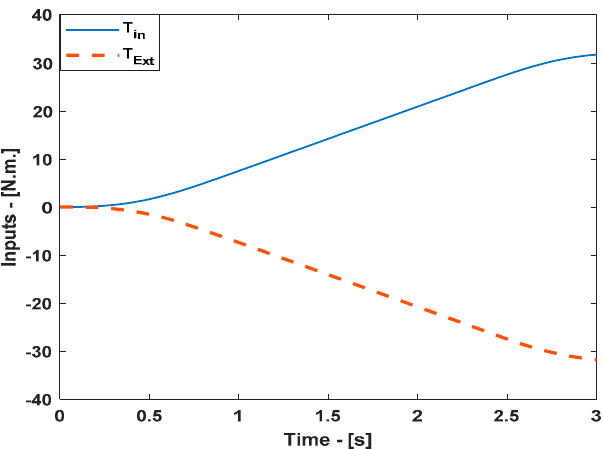
Figure 5. The input signals of BcVSA based on the LQR scheme under the condition when all the = 7 K clutches are active ( 𝐾 (cid:3032)(cid:3044) = 7 𝐾 (cid:2868) ) during the entire simulation time. clutches are active ( K eq 0 ) during the entire simulation time.